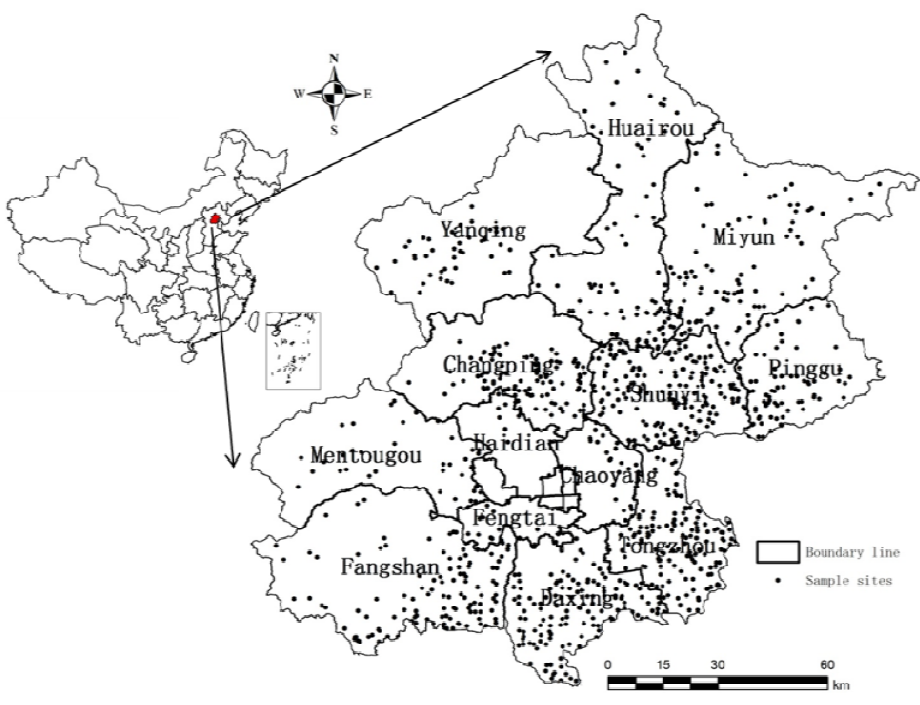
Figure 1. Distribution of sample sites in the study